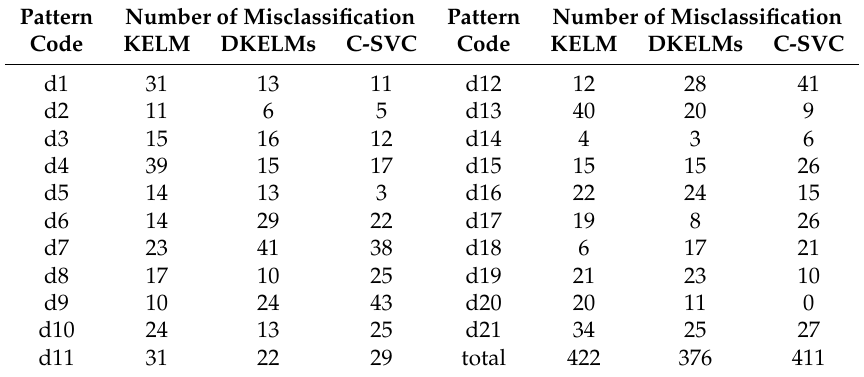
Table 12. Misclassification of each concurrent component failure pattern through different